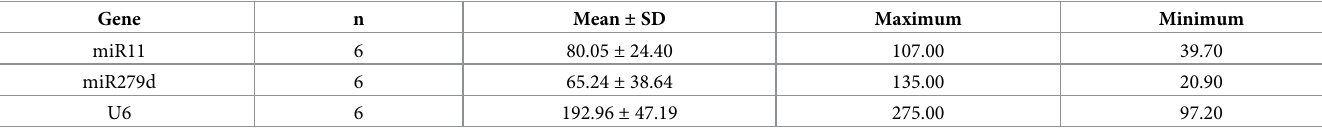
Data are shown in the form of absolute concentration (copies/ μ L). The mean, maximum and minimum of absolute concentrations of the sampled tissues of the GC strain are shown. n: number of the tested tissue samples, SD: standard